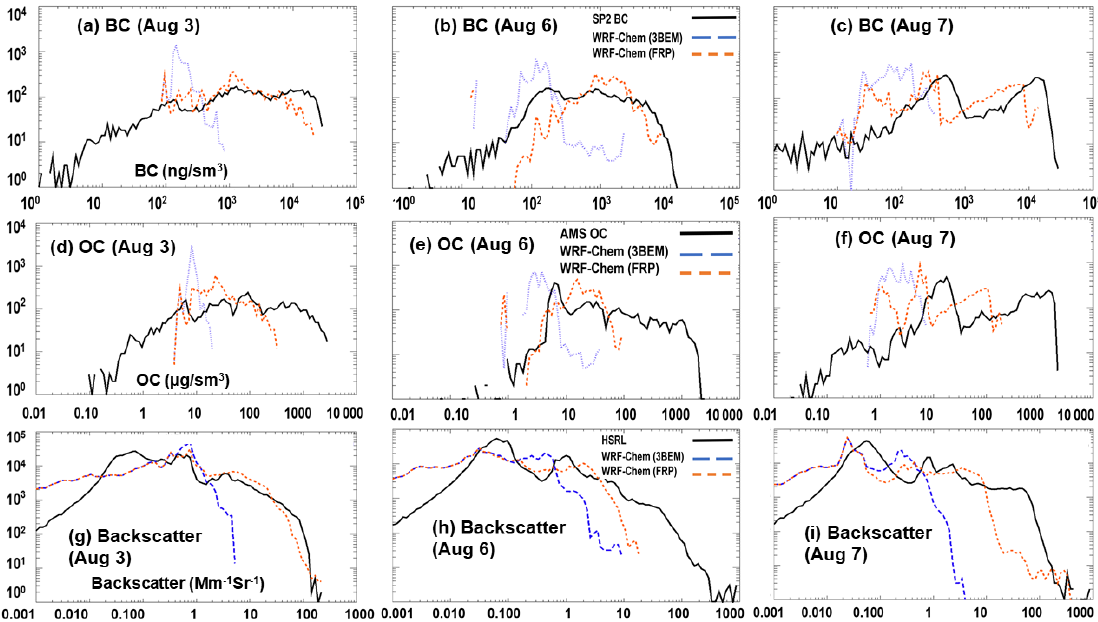
Figure 10. Frequency distributions for BC (a–c) , OC (d–f) , and backscatter coefficient (g–i) for the 3, 6, and 7 August DC-8 science flights. Note: BC and OC only represent in-plume cases.